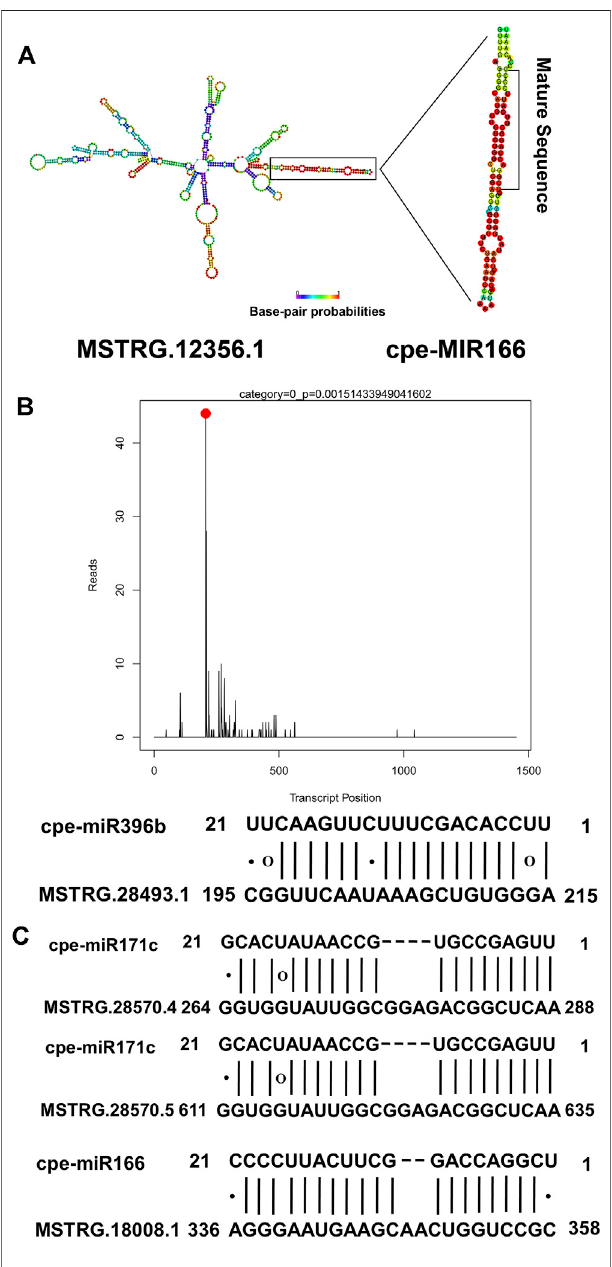
FIGURE 5 | Interactions between lncRNAs and miRNAs. (A) MSTRG.12356.1 was predicted to be a potential precursor of cpe- miR166. (B) MSTRG.28493.1 was predicted as a potential target of cpe- miR396b. The degradome T-plot of MSTRG.28493.1 showed a single clear peak at the degradation site. (C) Three lncRNAs, including one PM- responsivelncRNA(MSTRG.28570.4) werepredicted astarget mimics oftwo